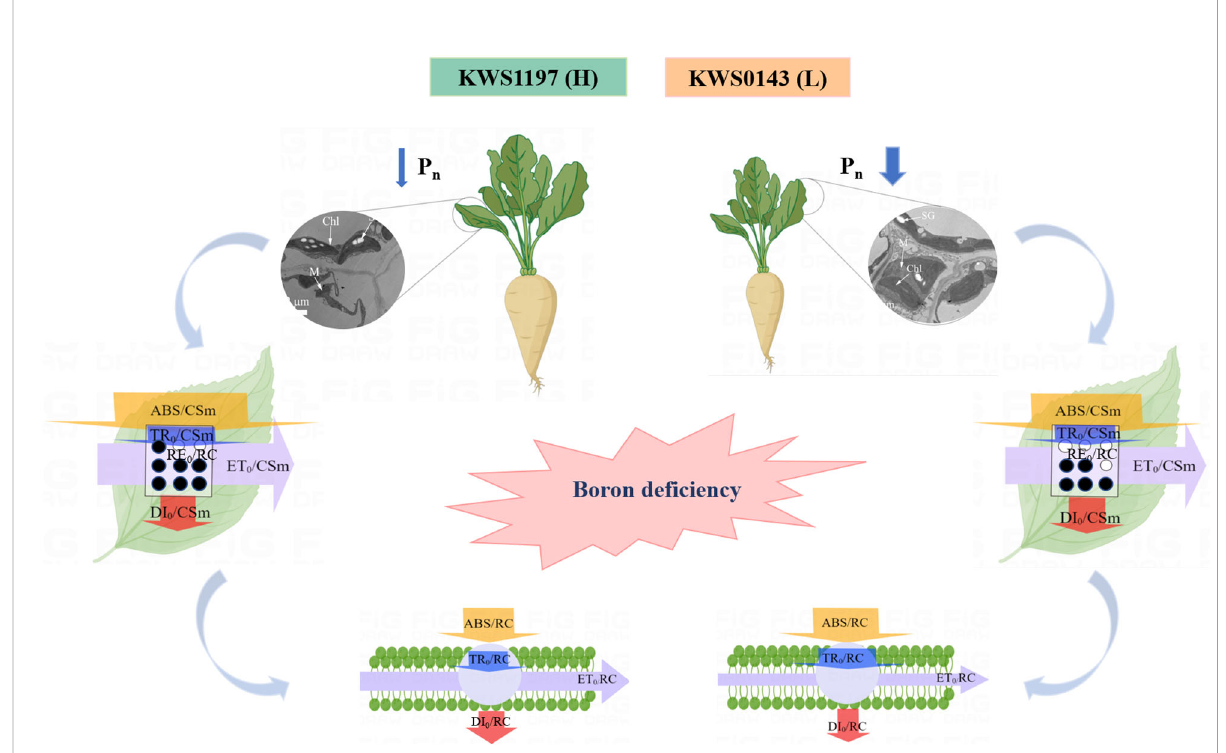
FIGURE 8 Photosynthetic physiological mechanism of ef fi cient B utilization in seedling leaves of sugar beet